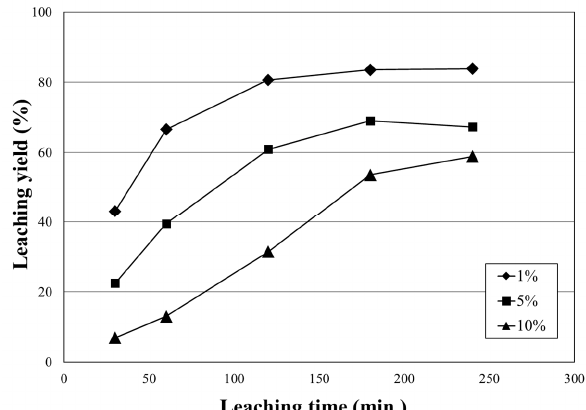
Figure 5. Leaching yields of Mo with time as a function of pulp density (current density: 0.292 A/g). Table 2. The amounts of MoS 2 input, and electron required and applied.